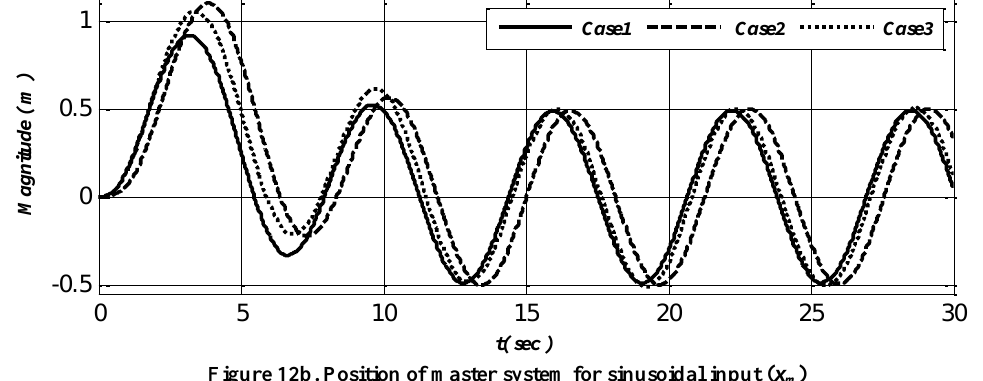
Figure 12b. Position of master system for sinusoidal input ( x m )